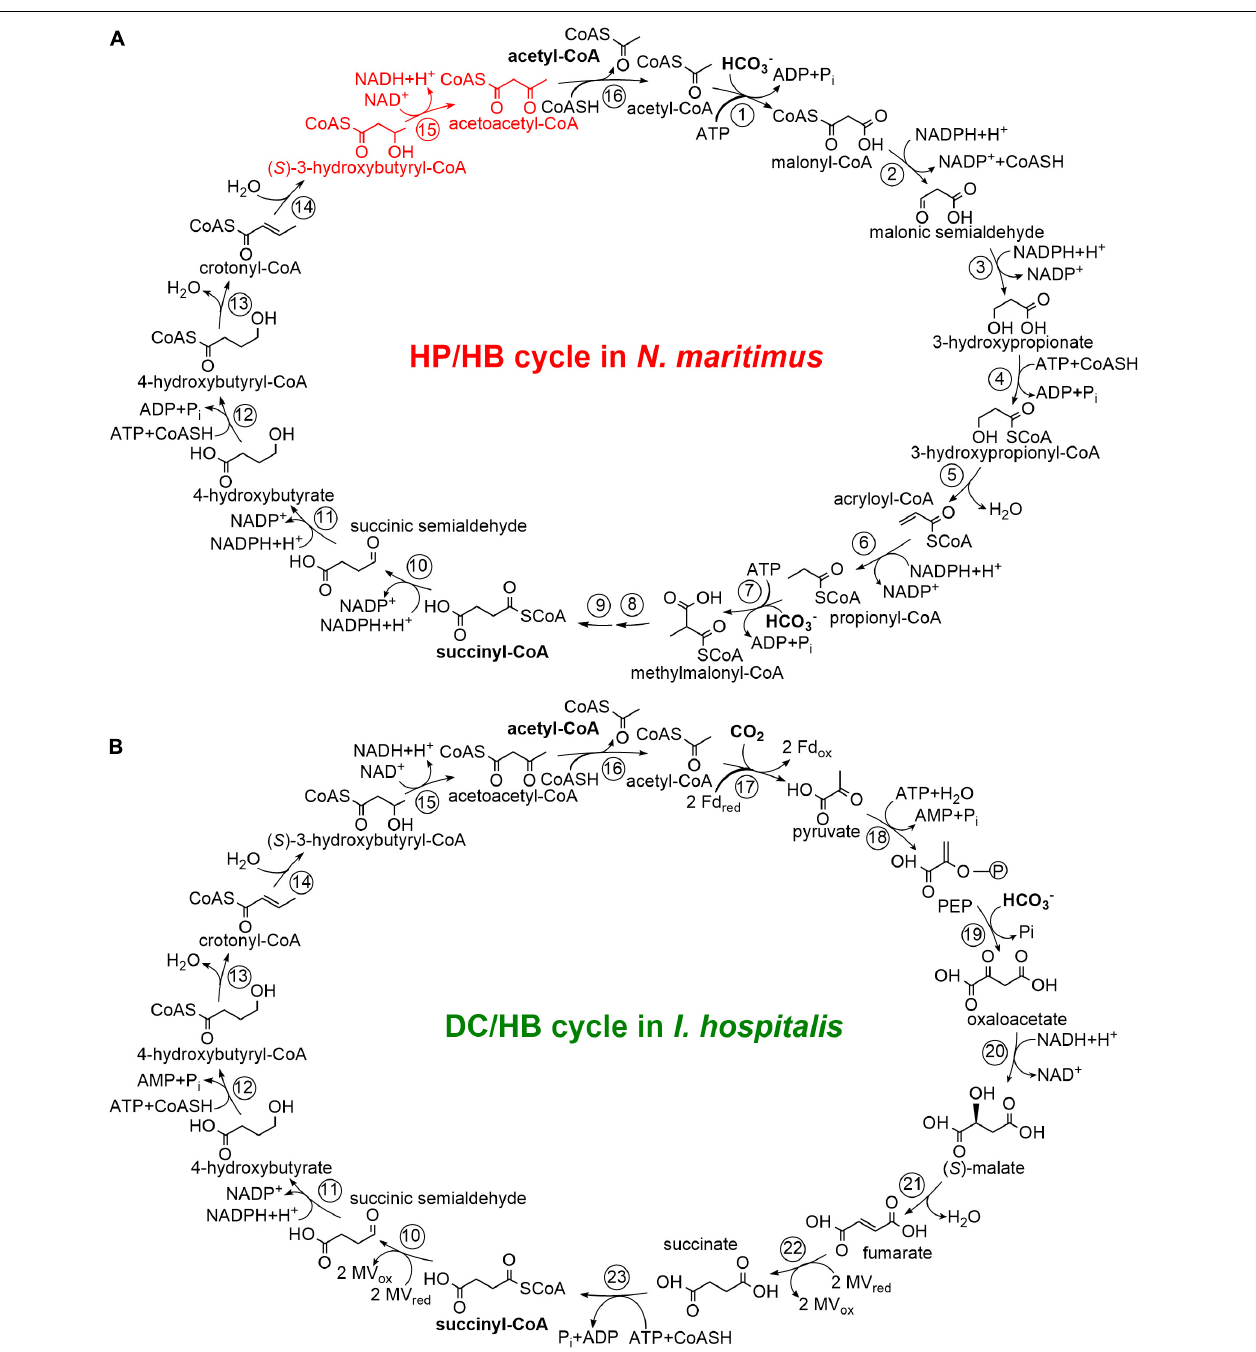
FIGURE 1 | The N. maritimus 3-hydroxypropionate/4-hydroxybutyrate cycle (A) and the I. hospitalis dicarboxylate/4-hydroxybutyrate cycle (B) adapted from Berg et al. (2010b) and Könneke et al. (2014). Enzymes: 1, acetyl-CoA carboxylase; 2, malonyl-CoA reductase; 3, malonic semialdehyde reductase; 4, 3-hydroxypropionyl-CoA synthetase; 5, 3-hydroxypropionyl-CoA dehydratase; 6, acryloyl-CoA reductase; 7, propionyl-CoA carboxylase; 8, methylmalonyl-CoA epimerase; 9, methylmalonyl-CoA isomerase; 10, succinyl-CoA reductase; 11, succinic semialdehyde reductase; 12, 4-hydroxybutyryl-CoA synthetase; 13, 4-hydroxybutyryl-CoA dehydratase; 14, crotonyl-CoA hydratase; 15, ( S )-3-hydroxybutyryl-CoA dehydrogenase; 16, acetoacetyl-CoA β -ketothiolase; 17, pyruvate synthase; 18, PEP synthase; 19, PEP carboxylase; 20, malate dehydrogenase; 21, fumarate hydratase; 22, fumarate reductase; 23, succinyl-CoA synthetase. CoASH, coenzyme A; PEP, phosphoenolpyruvate; Fd, ferredoxin; MV, methyl viologen.